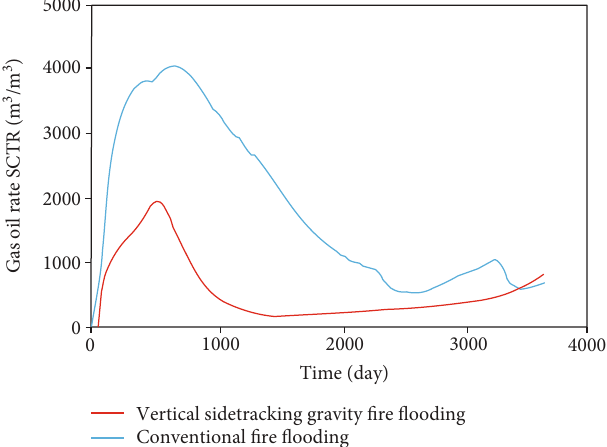
Figure 3: Comparison of air oil ratio between conventional fi re fl ooding and vertical sidetracking gravity fi re fl